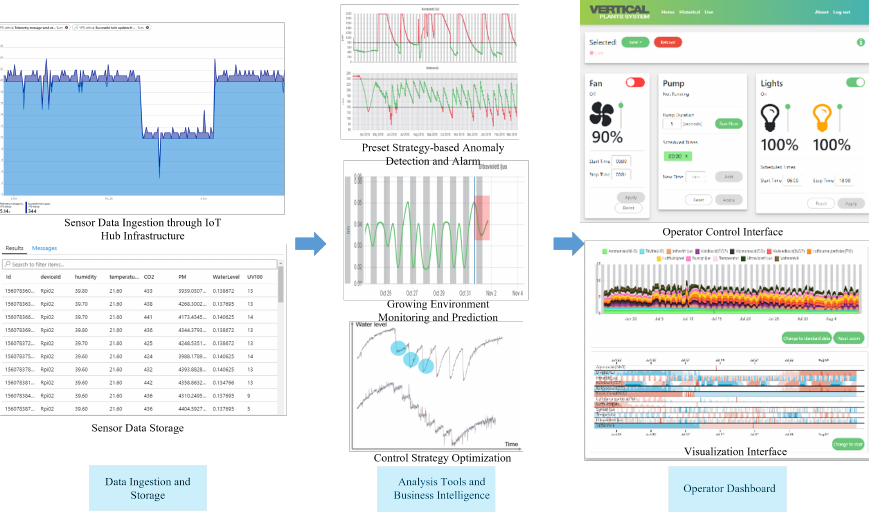
Figure 3. A preliminary study of the architecture of a plant factory: cloud